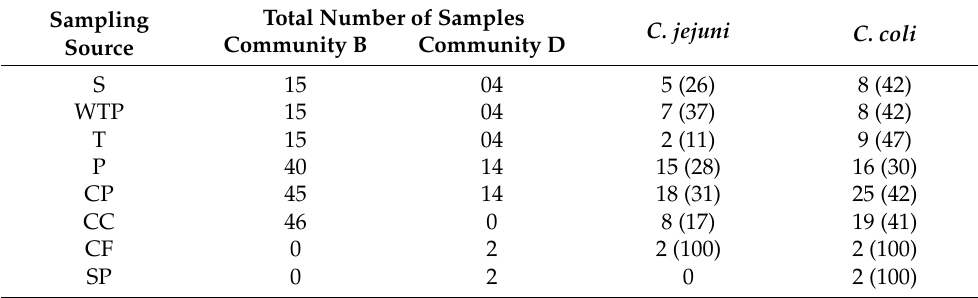
Table 2. Total number (percent) of water samples positive for C. jejuni and C. coli in pre- and post-treatment DWDS of two First Nations communities.